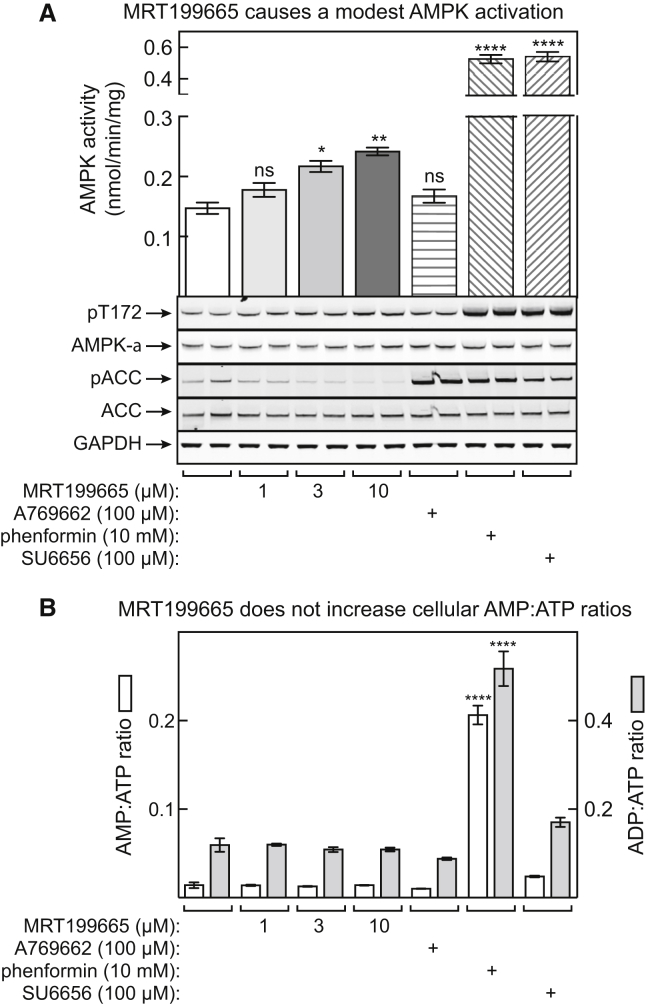
Another AMPK Inhibitor, MRT199665, Activates AMPK but Inhibits ACC Phosphorylation in HEK293 Cells(A) Effect of MRT199665, phenformin (10 mM), A769662 (300 μM), or SU6656 (100 μM) on AMPK activity in HEK293 cells. Cells were incubated for 60 min and AMPK activity measured; results in the top panel are means ± SEM (n = 8), with significant differences from the DMSO control indicated (ns, not significant). The bottom panels show western blots from the same experiment (n = 2).(B) Analysis of AMP:ATP and ADP:ATP ratios from a parallel experiment to that in (A). Results are means ± SEM (n = 3), with significant differences from the DMSO control indicated.*p < 0.05, **p < 0.01, ****p < 0.0001.